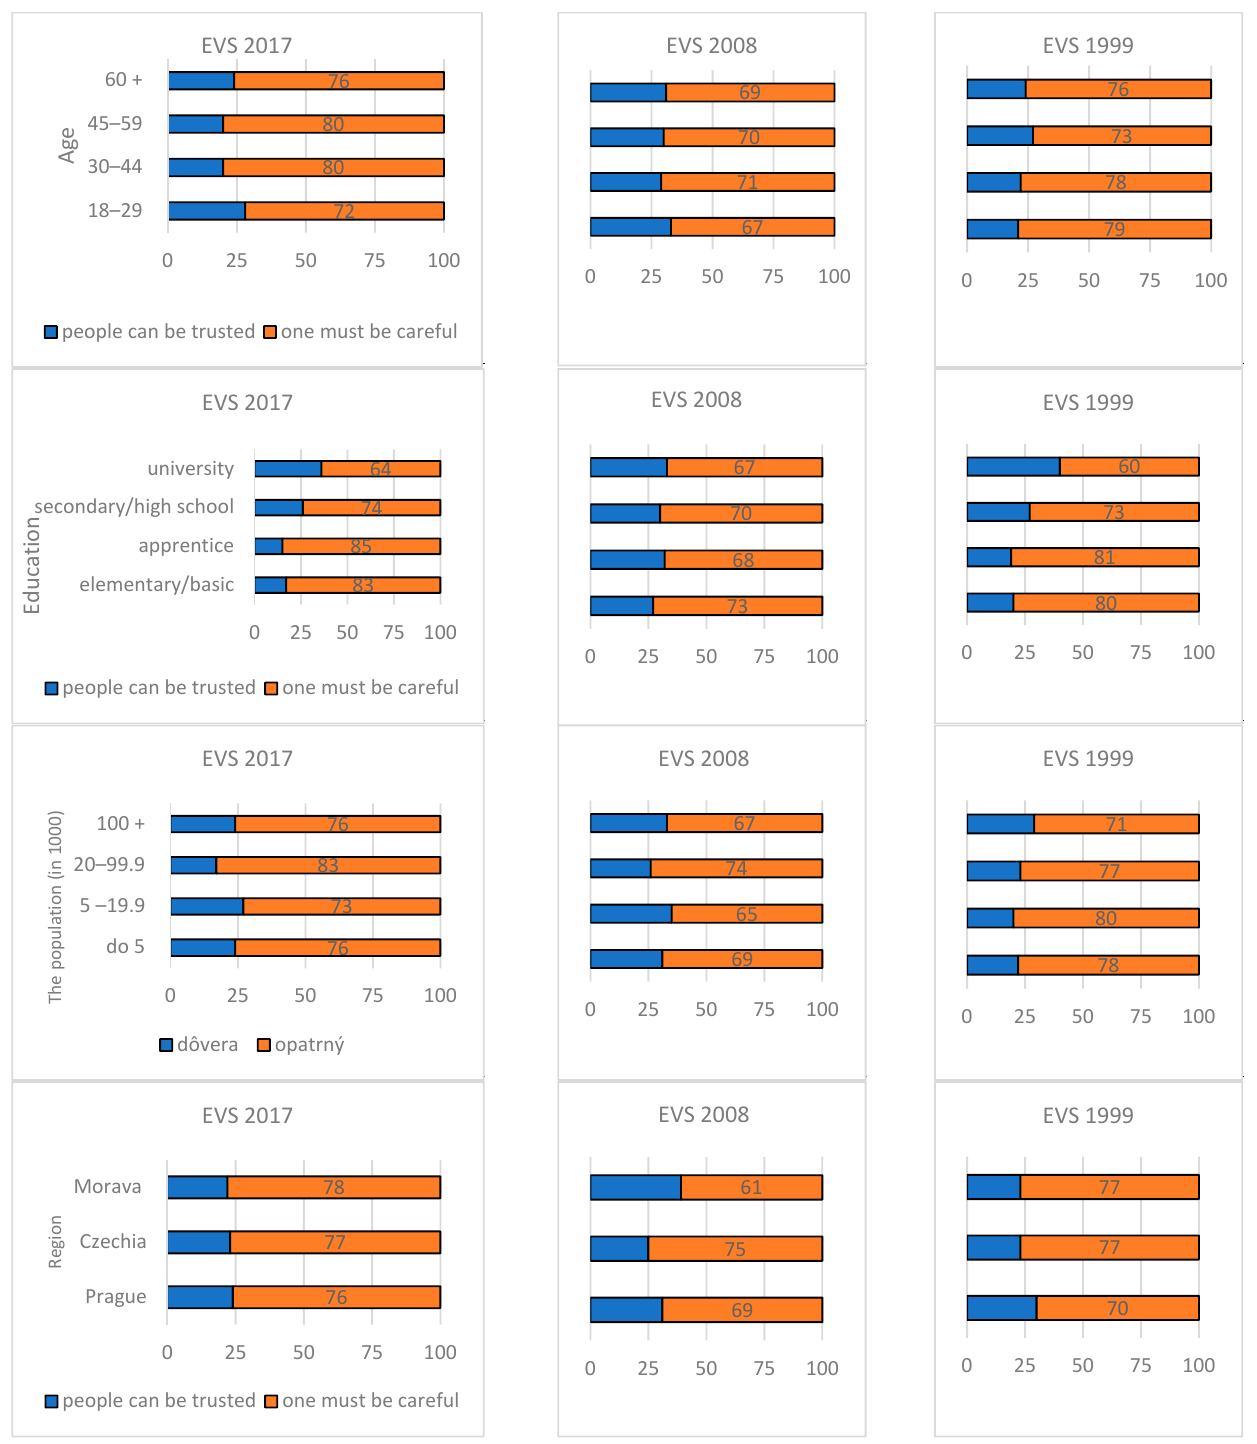
Figure 2. The development of social capital.